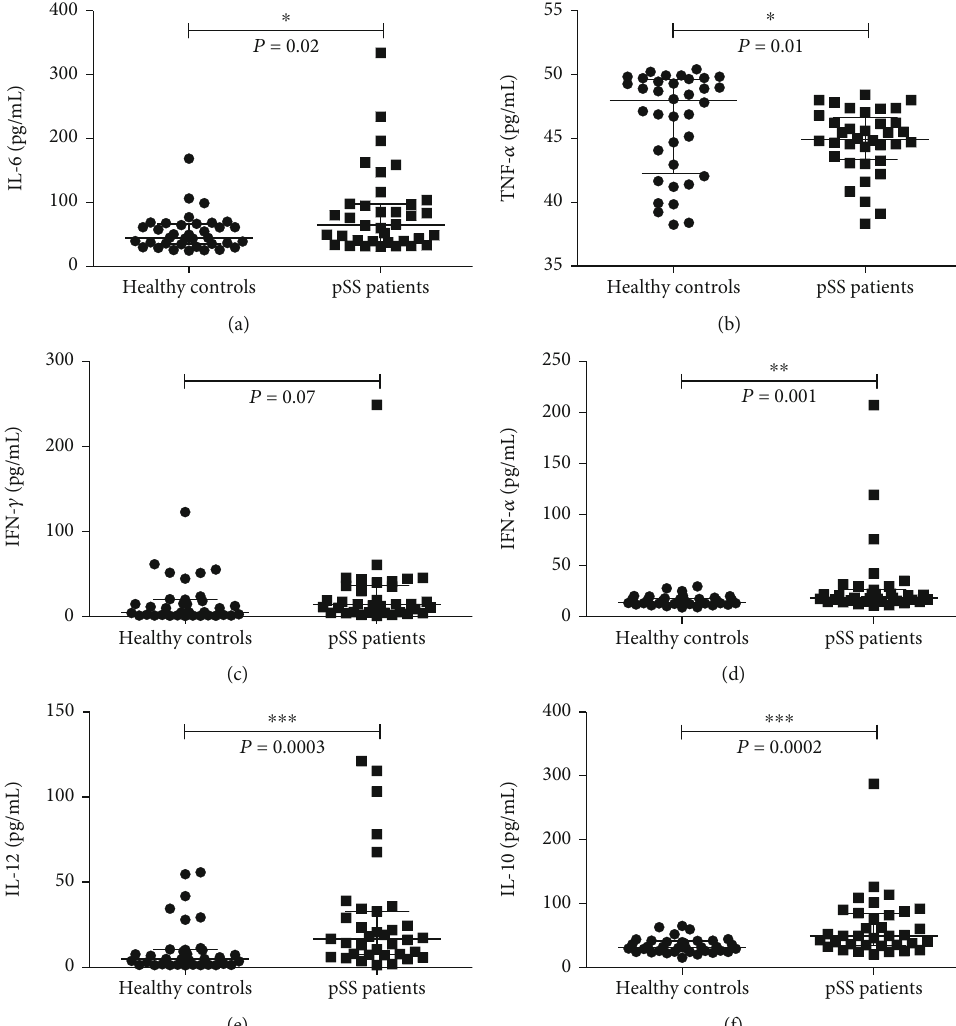
Figure 3: Comparison of cytokine levels between healthy control group and pSS patient group. (a – f) The levels of IL-6, TNF- α , IFN- γ , IFN- α , IL-12, and IL-10 were detected in healthy controls and pSS patients. Each dot represents one individual donor. The Mann-Whitney U test was used for comparison between the two groups. The error bars represent the median with interquartile